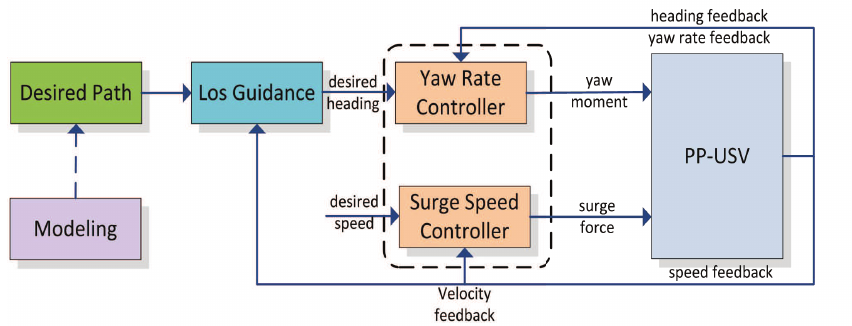
Figure 3. The block diagram of the podded propulsion USV path